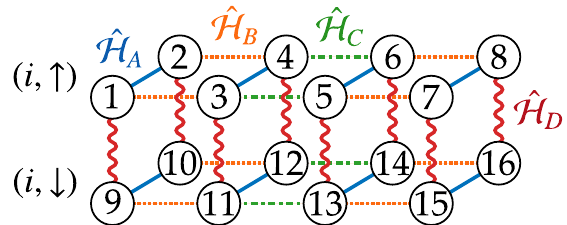
FIG. 12. The qubit indexing used for the Fermi-Hubbard model on a square lattice with a ladderlike 4 × 2 cluster under open boundary conditions. A circle with a number denotes a qubit and the lines between qubits indicate the terms of the subdivided Hamiltonians representation. Qubits 1–8 are assigned to fermions at site i (1 (cid:3) i (cid:3) 8) with spin ↑ (upper layer), and qubits 9–16 are assigned to fermions at site i (1 (cid:3) i (cid:3) 8) with spin ↓ (lower layer). The subdivided Hamiltonians hopping ( J ) terms, while ( U H ) terms, indicated, respectively, by the solid lines (blue), the dashed lines (orange), the dash-dotted lines (green), and the wavy lines